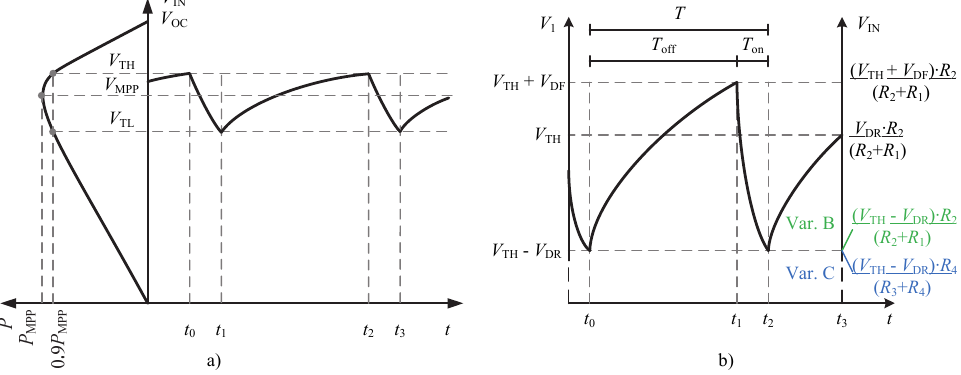
Fig. 4. Optimizer time diagram: variant A Fig. 2a (a), variant B Fig. 2b and variant C Fig. 2c